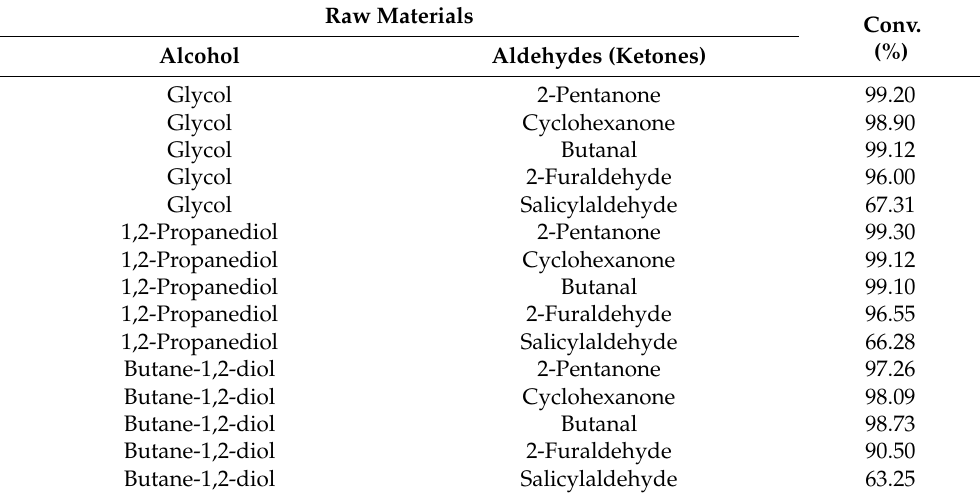
Table 3. Conversion of acetals (ketals) reactions with different substrates catalyzed by AC-N-SO 4 H. Raw Materials